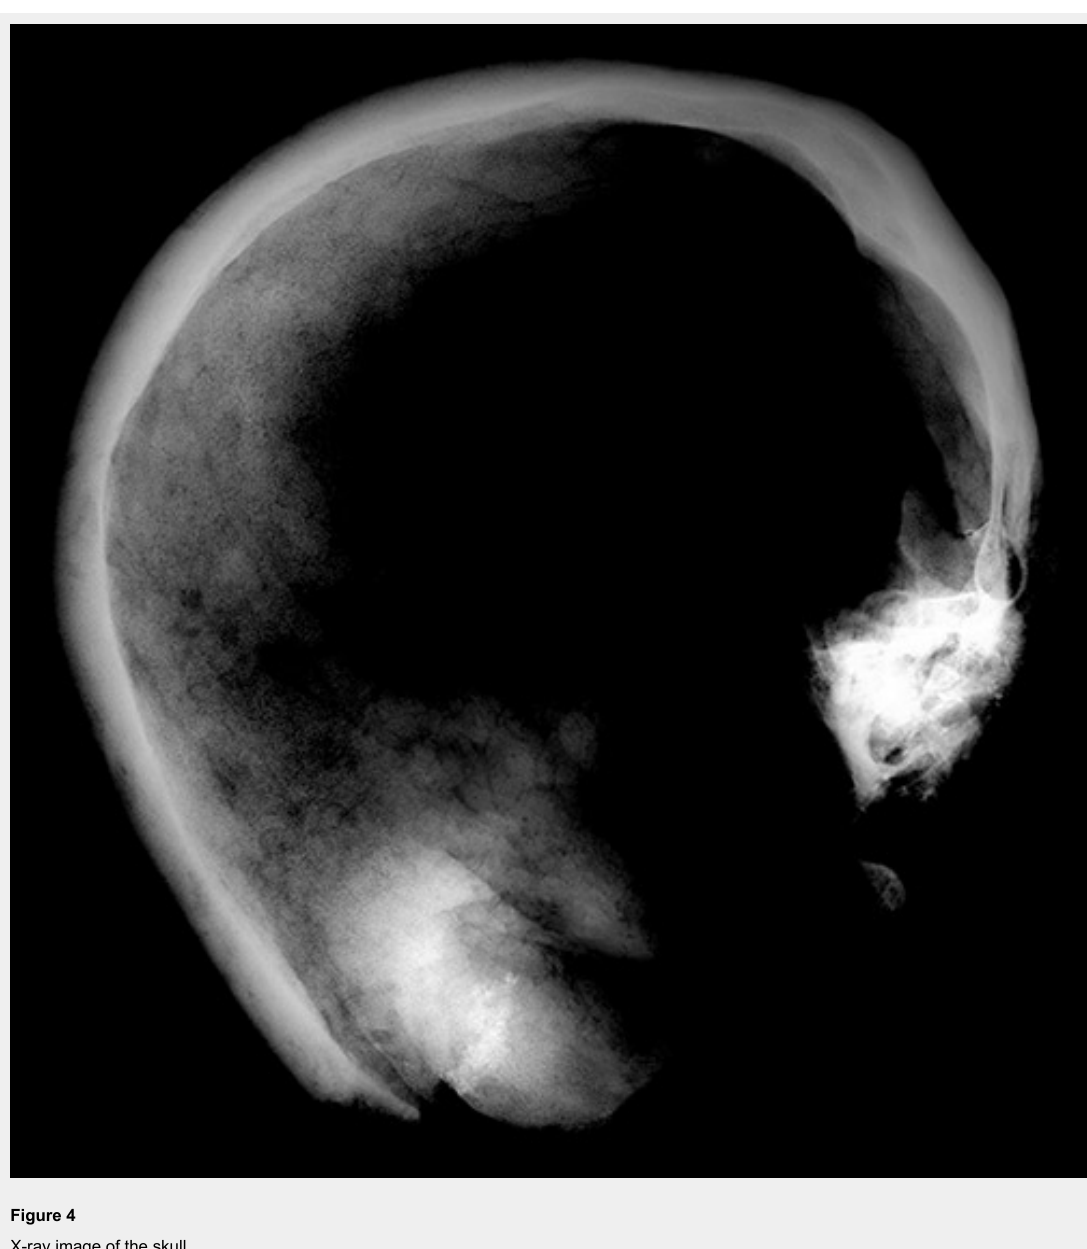
Figure 4 X-ray image of the